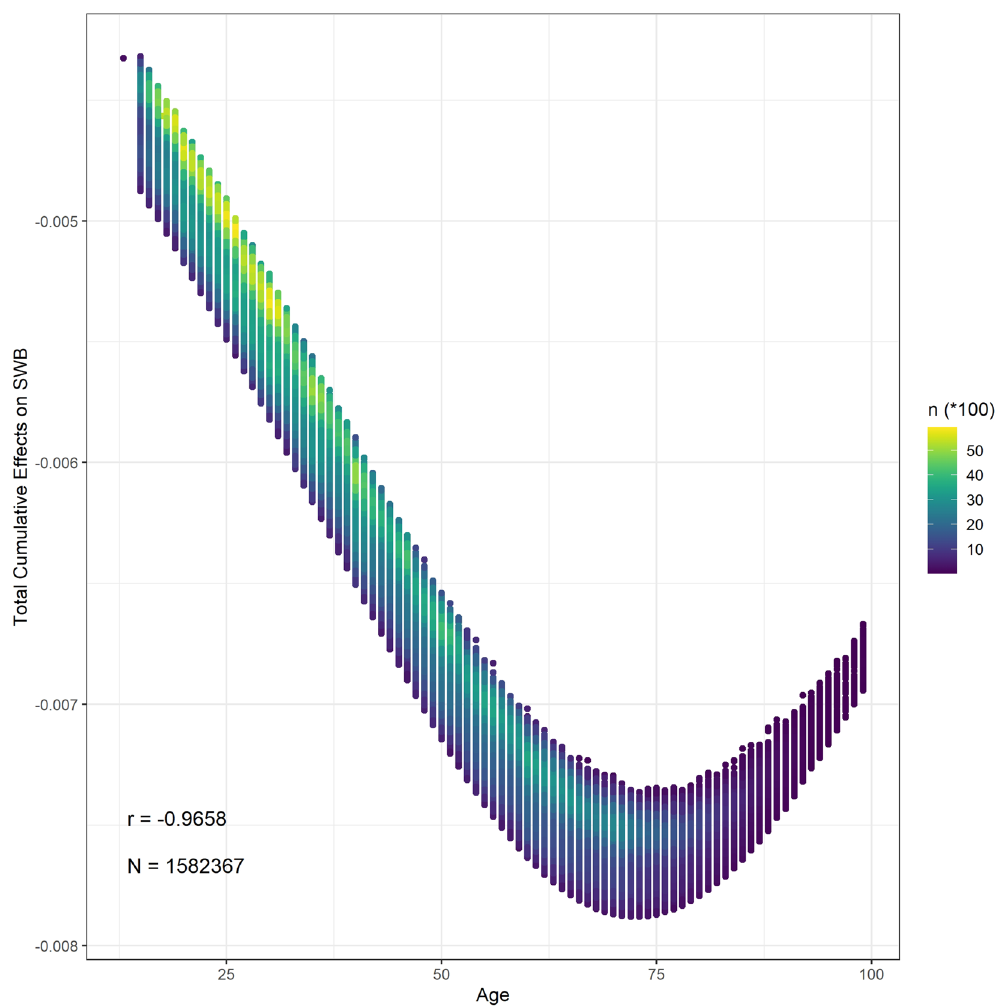
Figure 2. The distribution between the total cumulative effects of age on SWB and